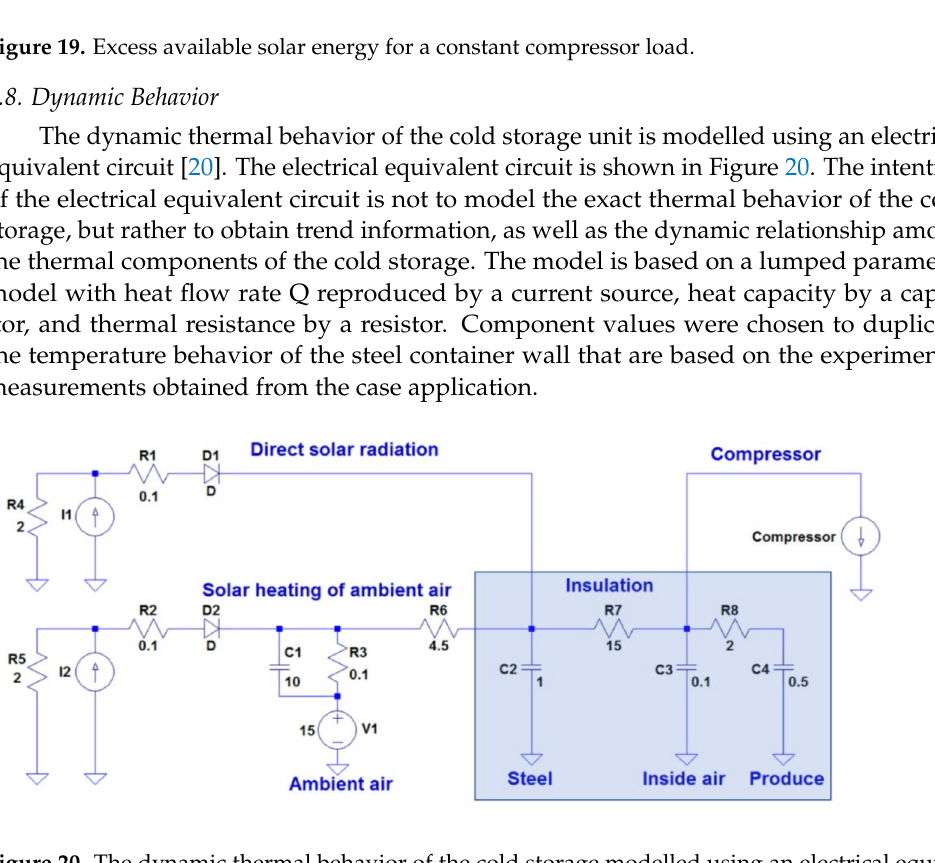
Figure 20. The dynamic thermal behavior of the cold storage modelled using an electrical equiva- lent